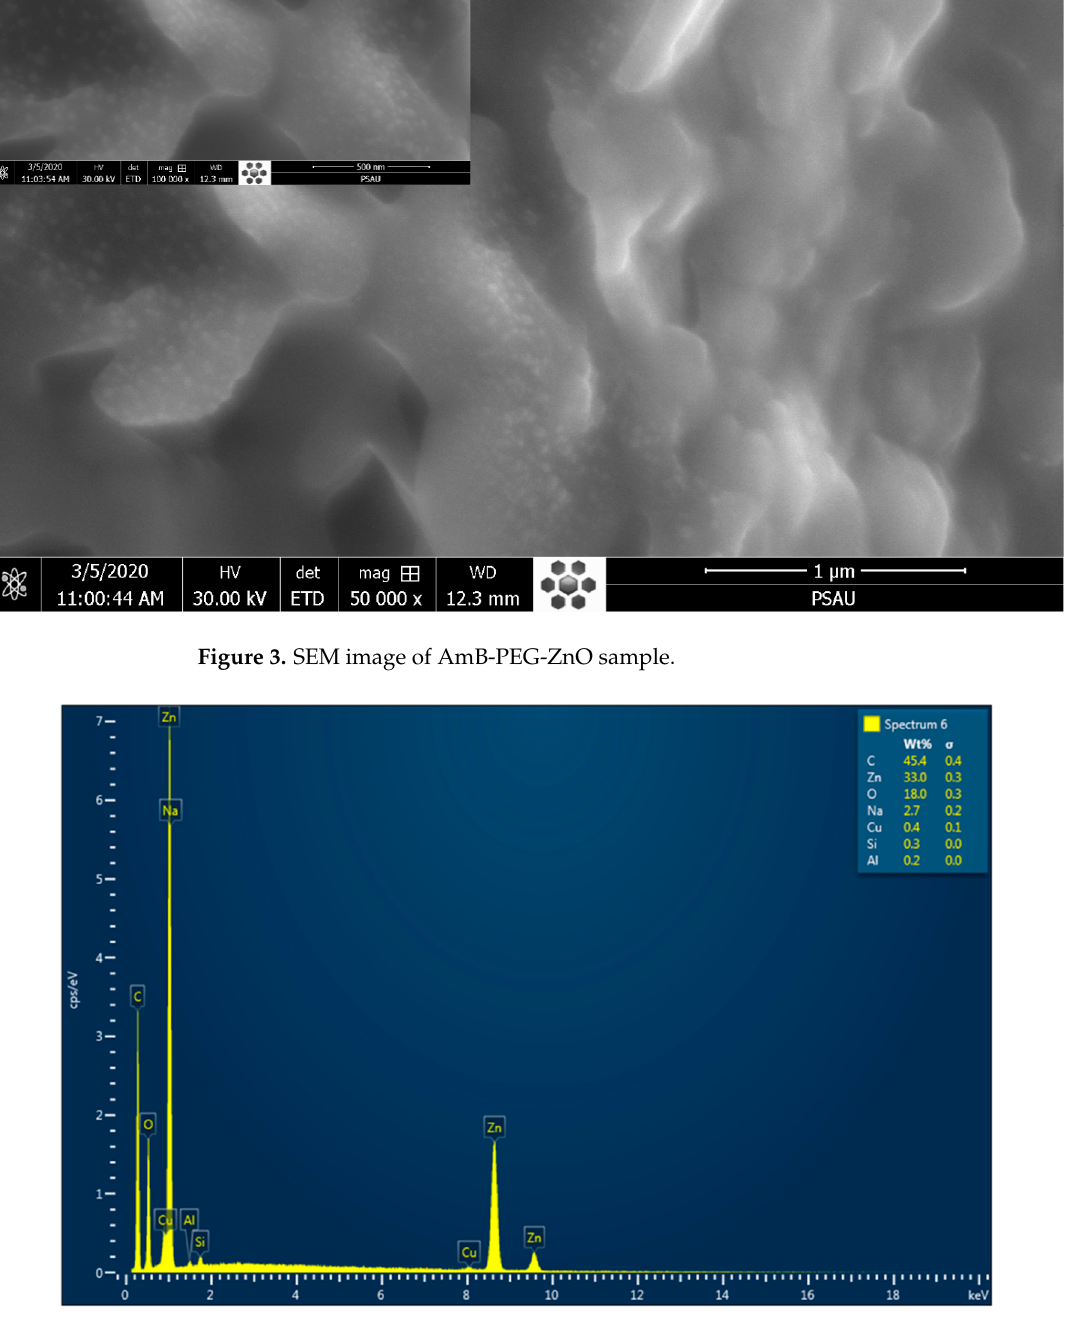
Figure 4. EDX spectrum of ZnO-AMB-PEG sample.